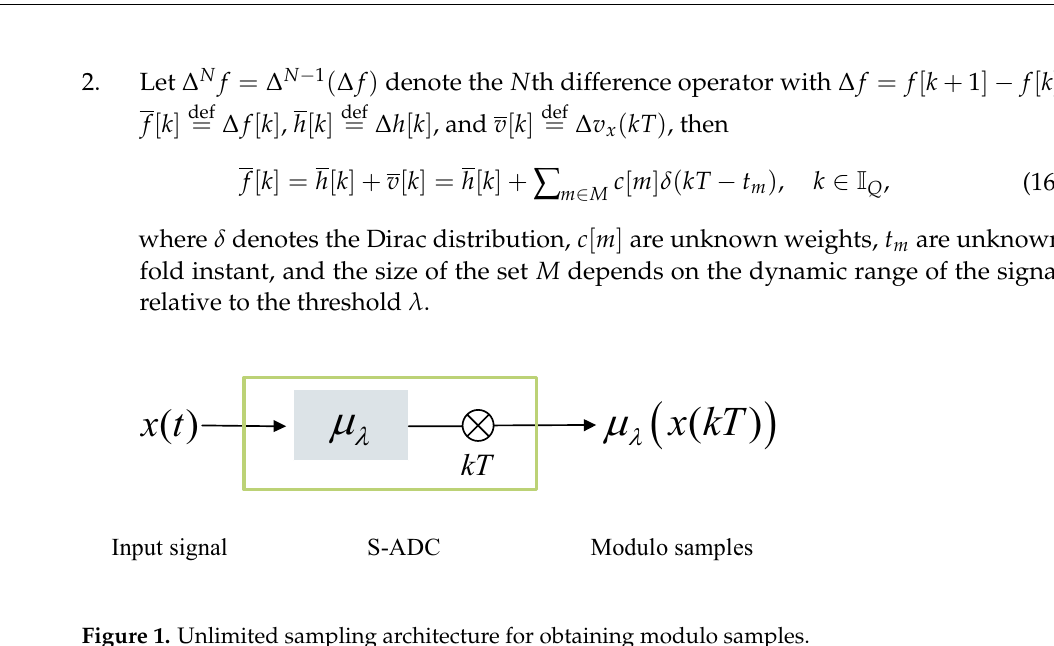
Figure 1. Unlimited sampling architecture for obtaining modulo